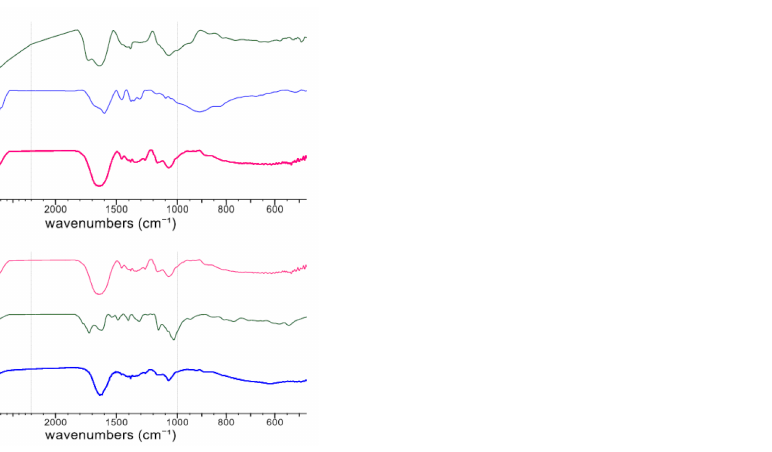
Figure 2. FTIR spectra for: ( a ) compounds involved in obtaining the Schiff base: glyoxal solution ( 1 ), ED ( 2 ) and the Schiff base/intermediate agent obtained from glyoxal interaction with ED ( 3 ); ( b ) compounds involved in obtaining the D-CD: Schiff base ( 1 ); MCT- β -CD ( 2 ) and D-CD (D14) ( 3